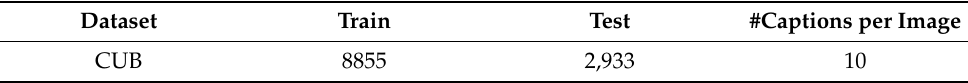
Table 1. Statistics of